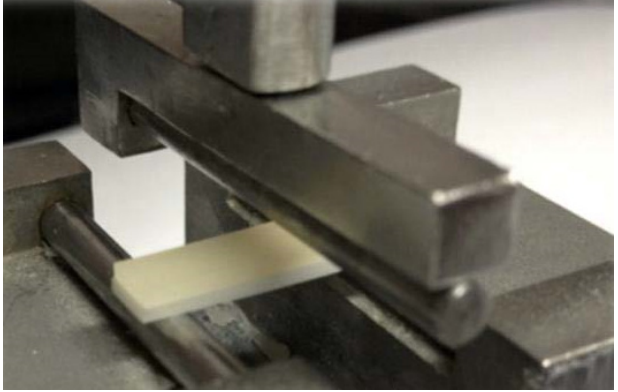
Figure 1. Three point bending test of bilayered specimen.